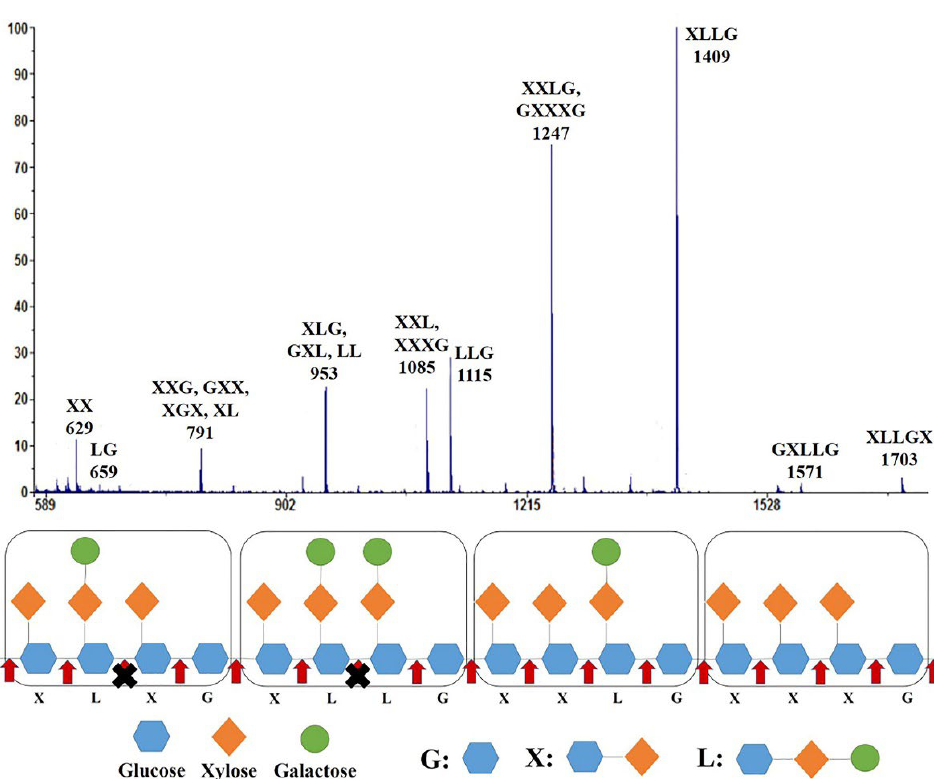
Figure 3. MALDI-TOF MS analysis of the products generated by Tt GH74 from tamarind seed XG. The red arrow shows the possible XG cleavage sites of Tt GH74, and the black cross indicates that Tt GH74 did not cleave at the reducing end side of L units in XLXG and